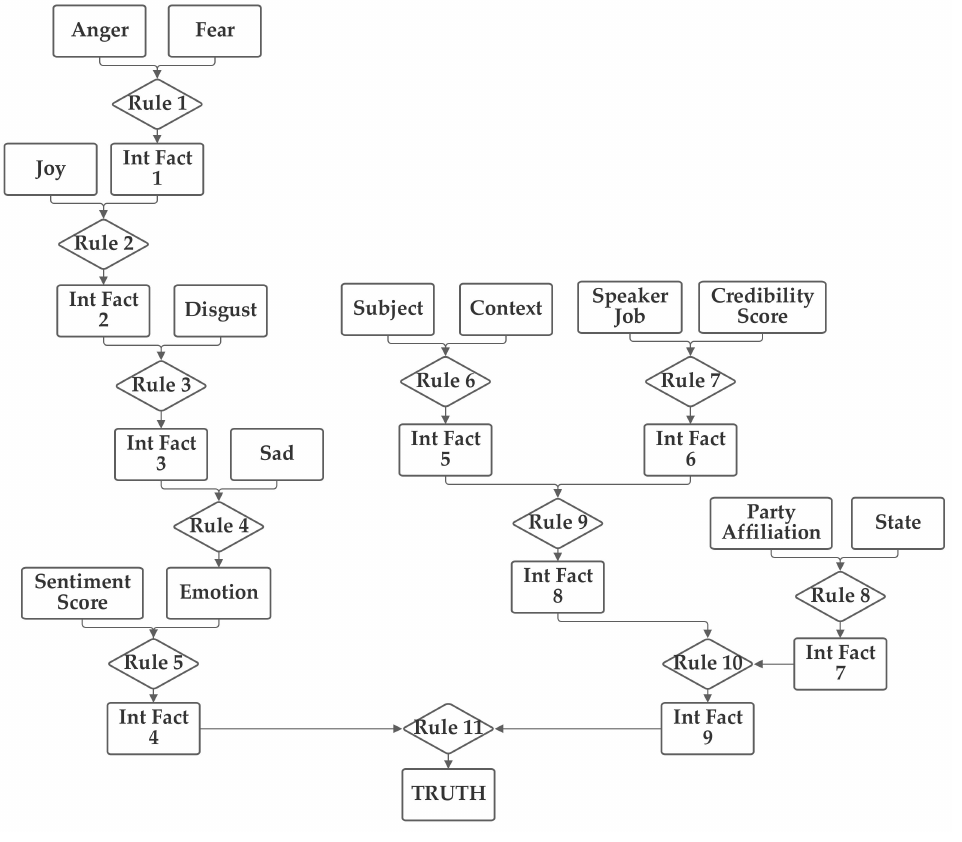
Figure 8. Depiction of Network